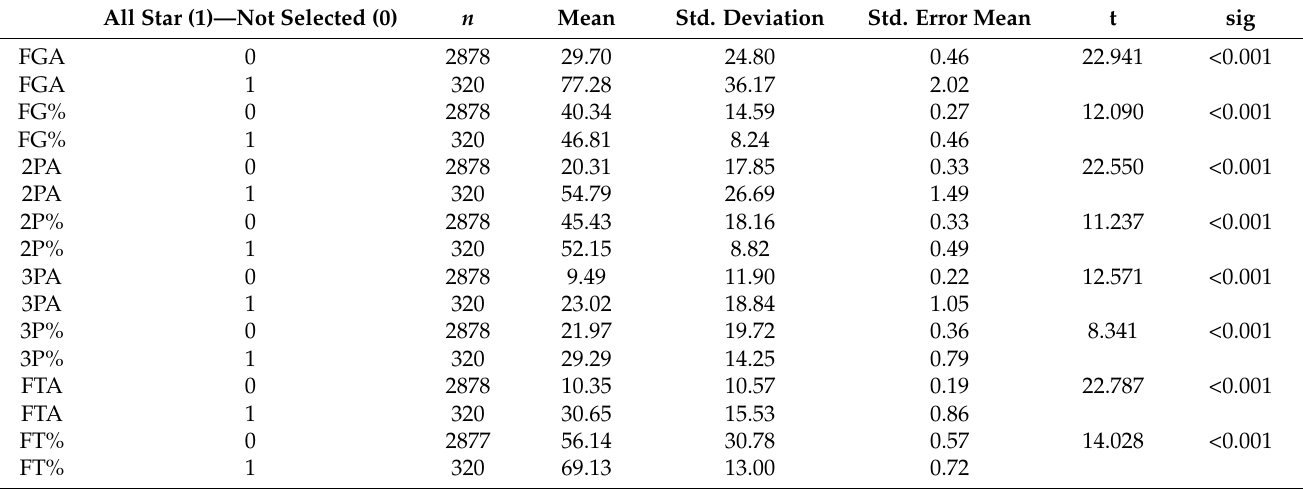
Table 1. Shooting attempts and accuracy of all-star and not selected youth basketball players (figure by the